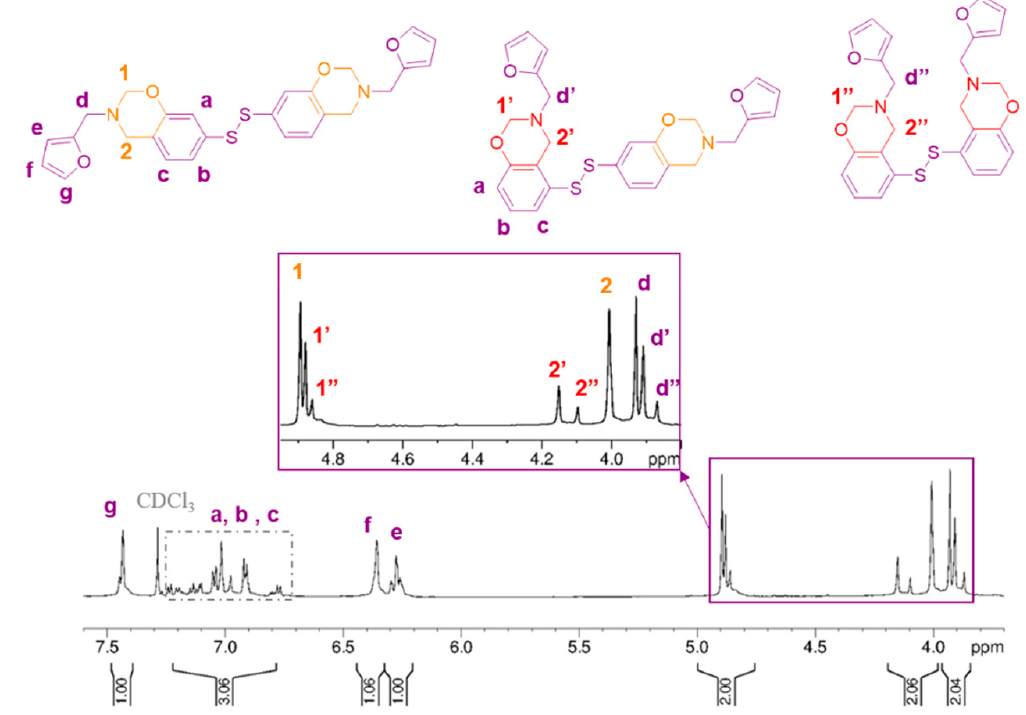
Figure A2. 1 H NMR spectrum in CDCl 3 of 3DPDS-fa.